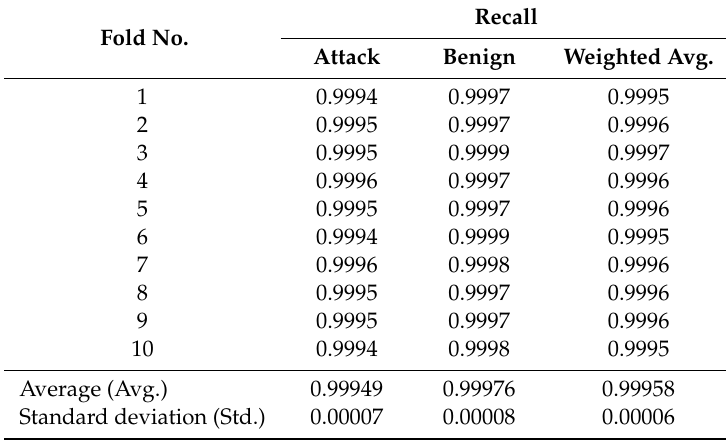
Table 6. Recall results of the 10-fold cross-validation for attack and benign classifications using the selected feature